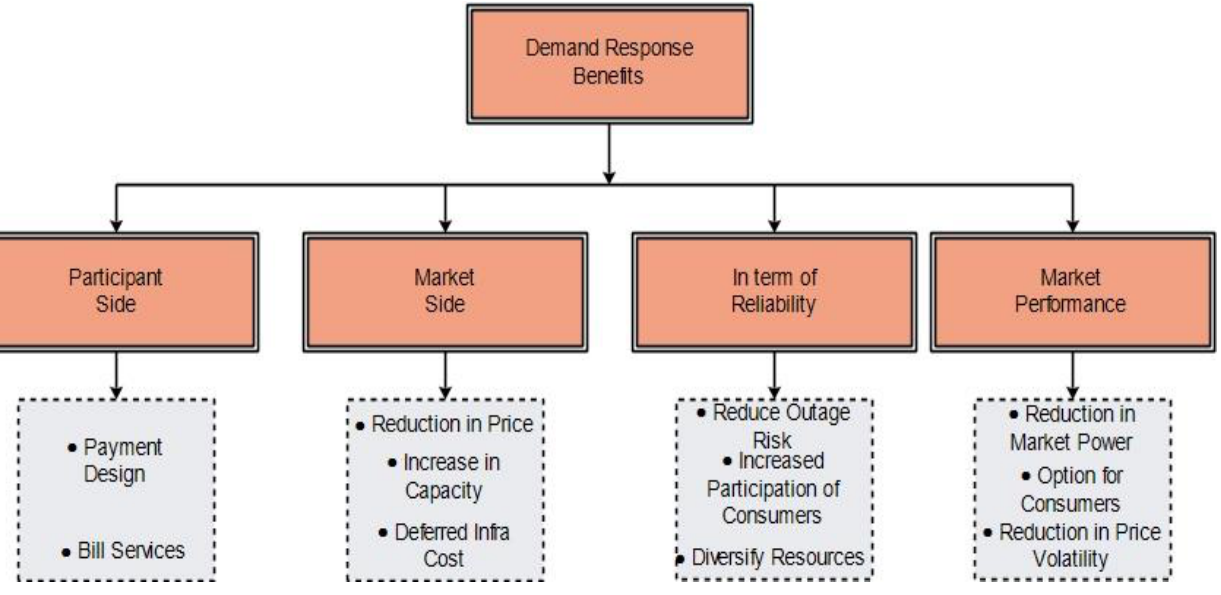
Figure 2. Classification of DR programmes.